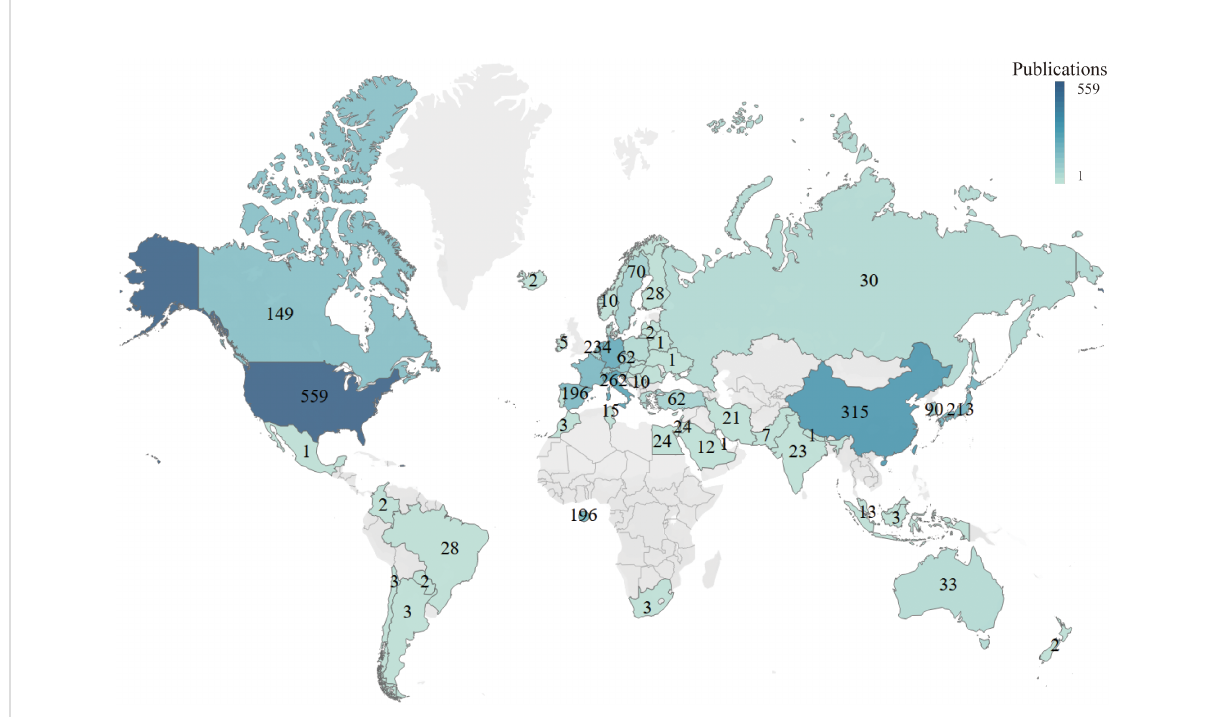
FIGURE 3 Global analysis of the research trends in NMIBC based on the origin of the publications.